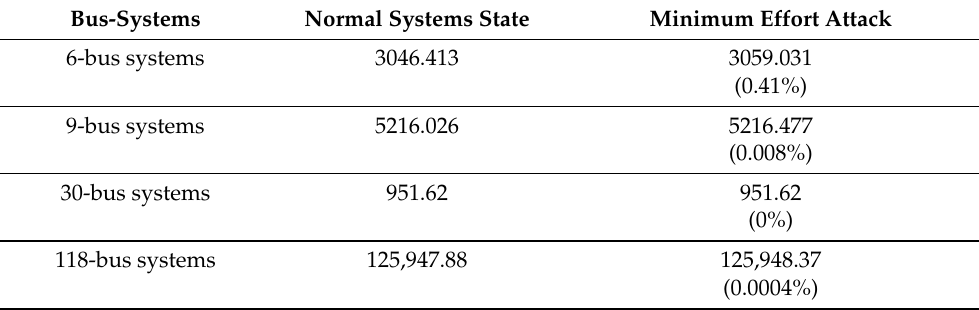
Table 3. Generation cost increase under minimum effort False Data Injection Attacks (FDIA)